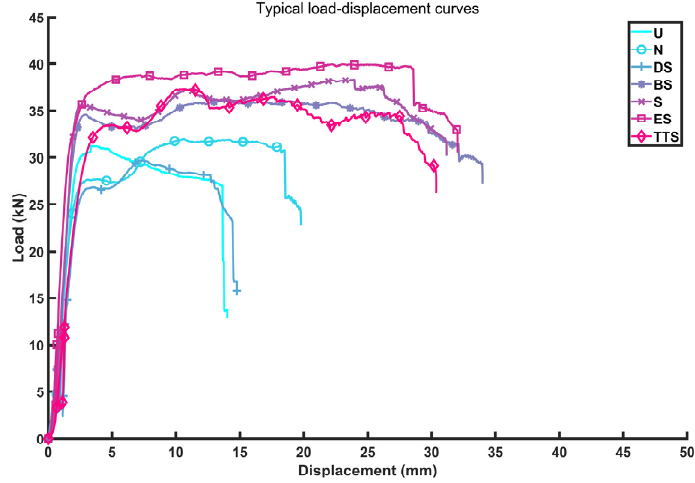
Figure 9. Load-displacement curves for embedment-strength tests.